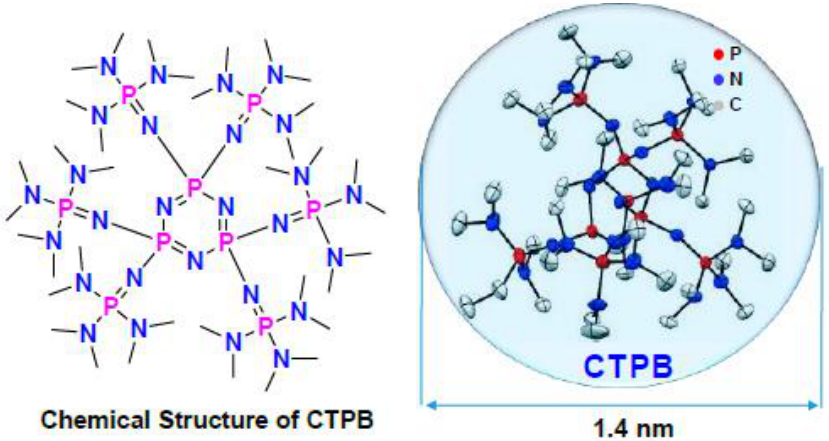
Figure 5. Structure of a trimeric phosphazene base (CTPB) (adapted with permission from Ref. [64]. 2019, Shi, J).